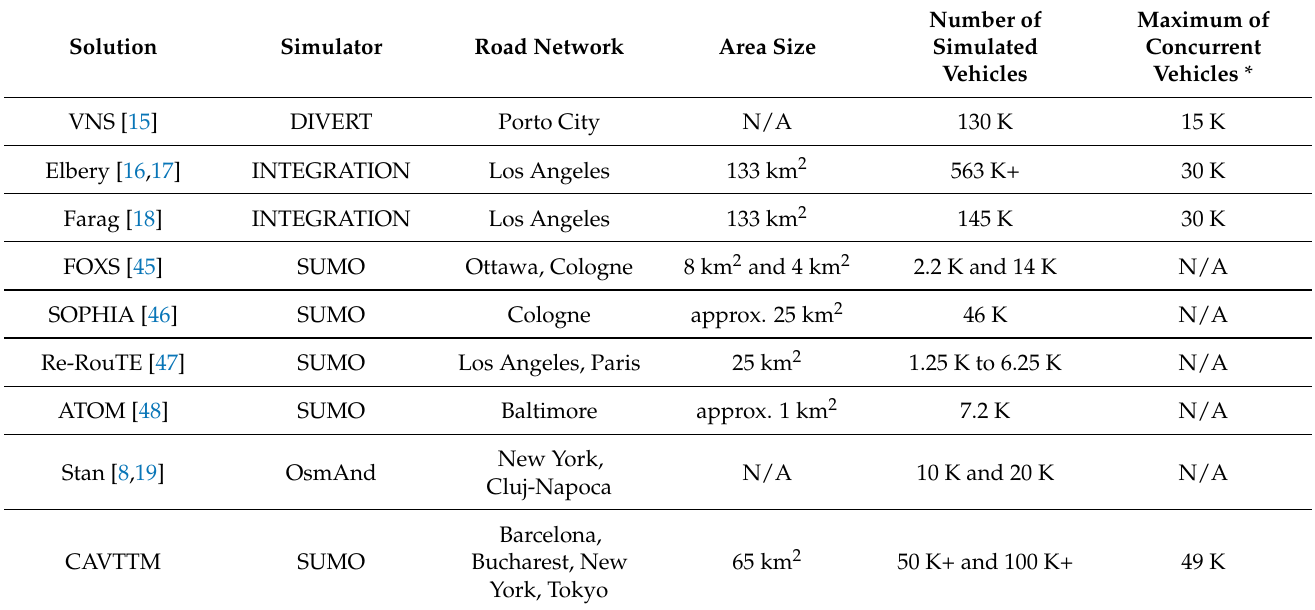
Table 1. Large scale urban traffic congestion simulation